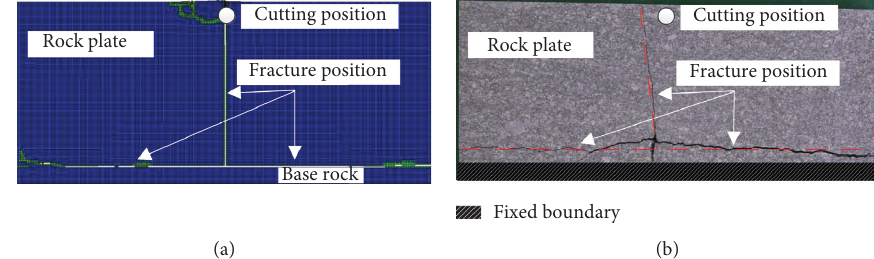
Figure 7: Comparison of experiment and numerical simulation results: (a) experimental result and (b) numerical simulation